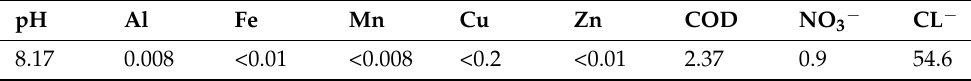
Table 1. Water quality of Qixia in June 2020